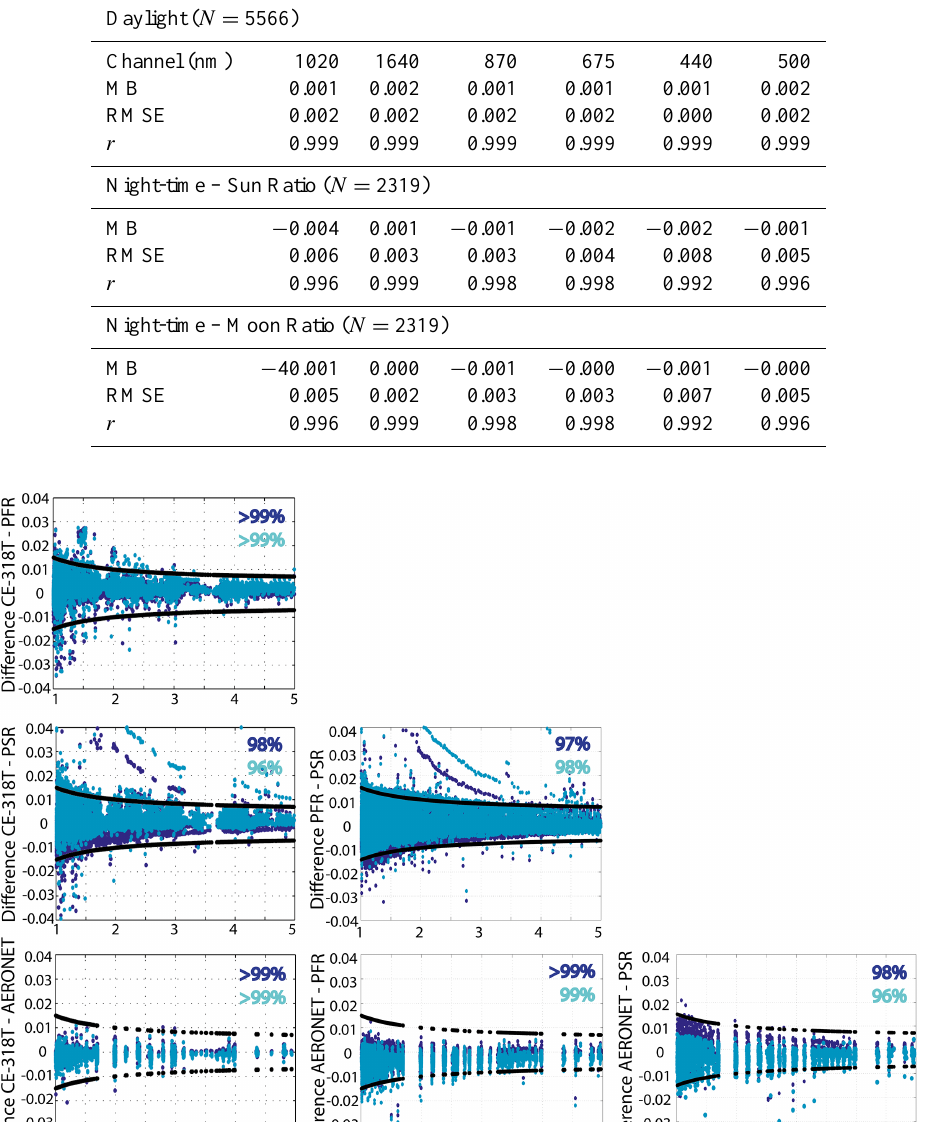
Table 4. Statistics of the master vs. secondary AOD comparison: mean bias (MB), root mean square error (RMSE) and Pearson correlation coefficient ( r ).